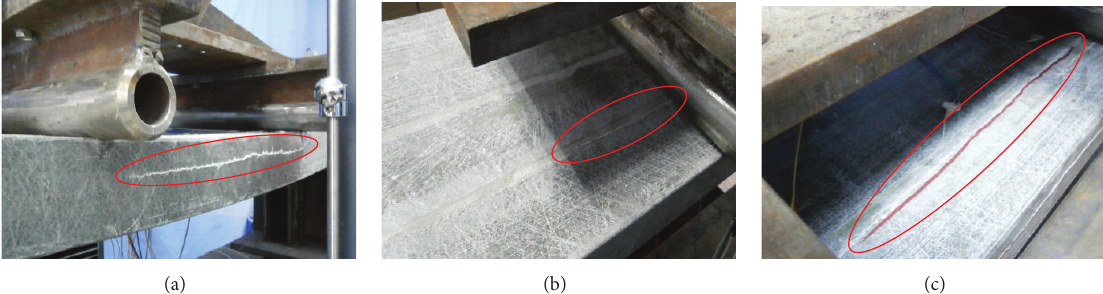
Figure 4: Failure of specimen S(0)-GFRP: (a) horizontal cracks appeared on the web, (b) cracks appeared on the facesheet, and (c) cracks spreading.